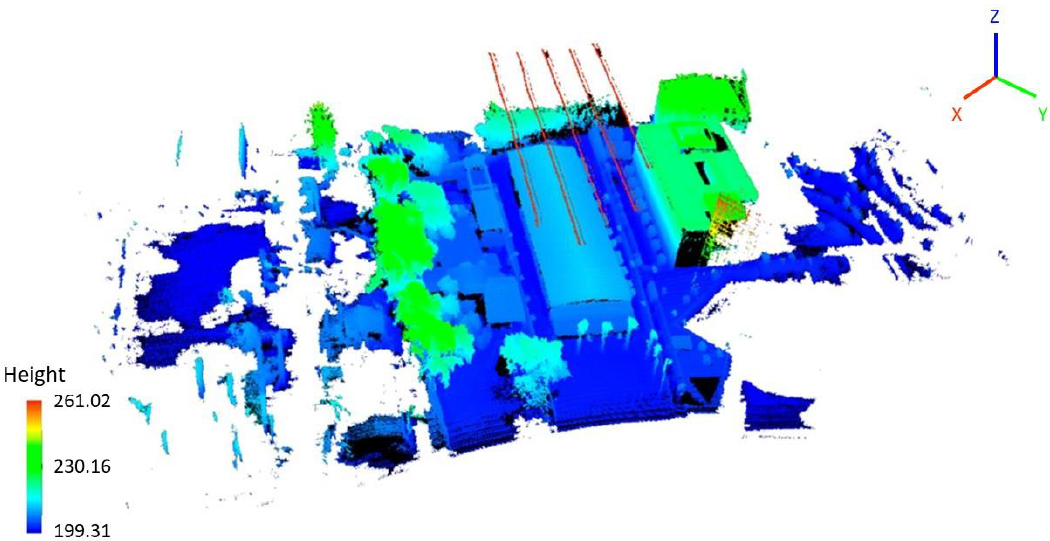
Figure 18. Point cloud display in the LiDAR 360 software, after removing outliers and filtering noise. Colors indicate the height range of the collected volumes.